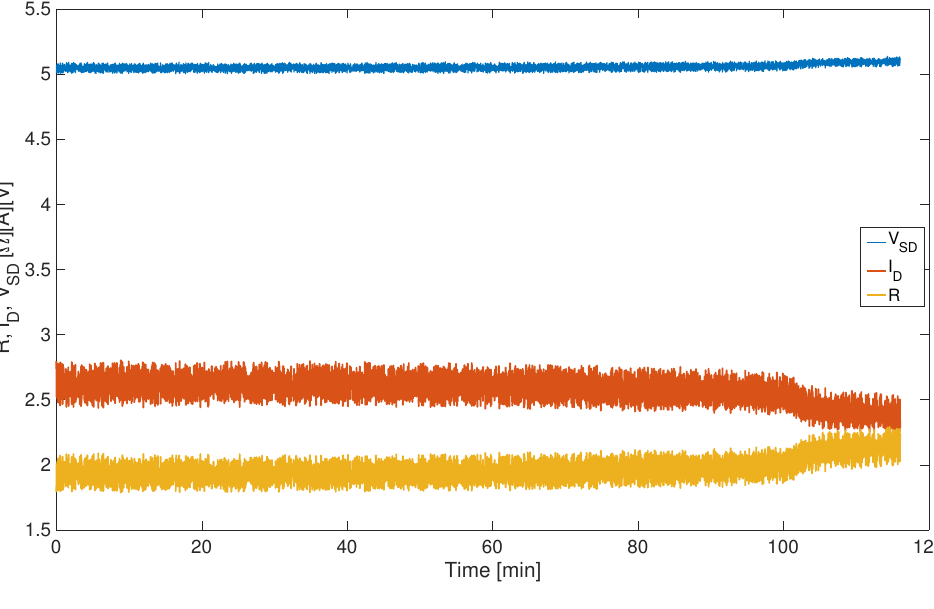
Figure 10. Current, voltage and resistance of the 26th